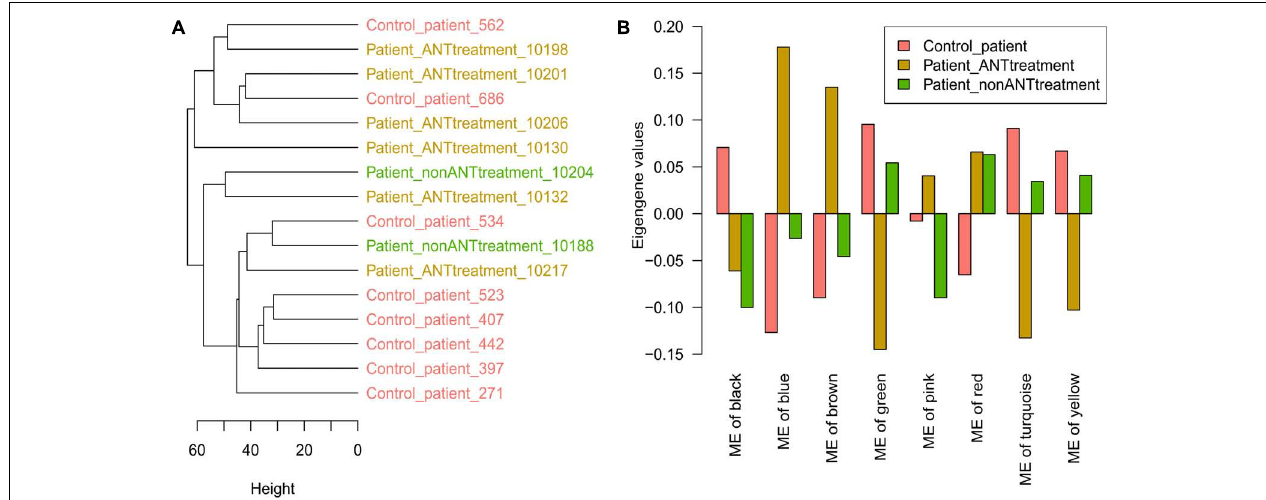
FIGURE 4 | Human cardiac biopsies proteomics data analysis. (A) The hierarchical clustering tree is based on the protein expression values in biopsy samples. (B) The module eigengene (ME) values in WGCNA modules. Control_patient: heart failure patients with no cancer history; Patient_ANTtreatment: heart failure patients that had cancer treatment with anthracyclines (ANTs); Patient_nonANTtreatment: heart failure patients that had cancer treatment without ANTs; the number at the end of each patient indicates the biopsies sample ID. TABLE 2 | The number of proteins in WGCNA modules in the human biopsies dataset. Total Turquoise Blue module Brown Yellow Green Red module Black Pink module proteins module module module module module 1,602 342 330